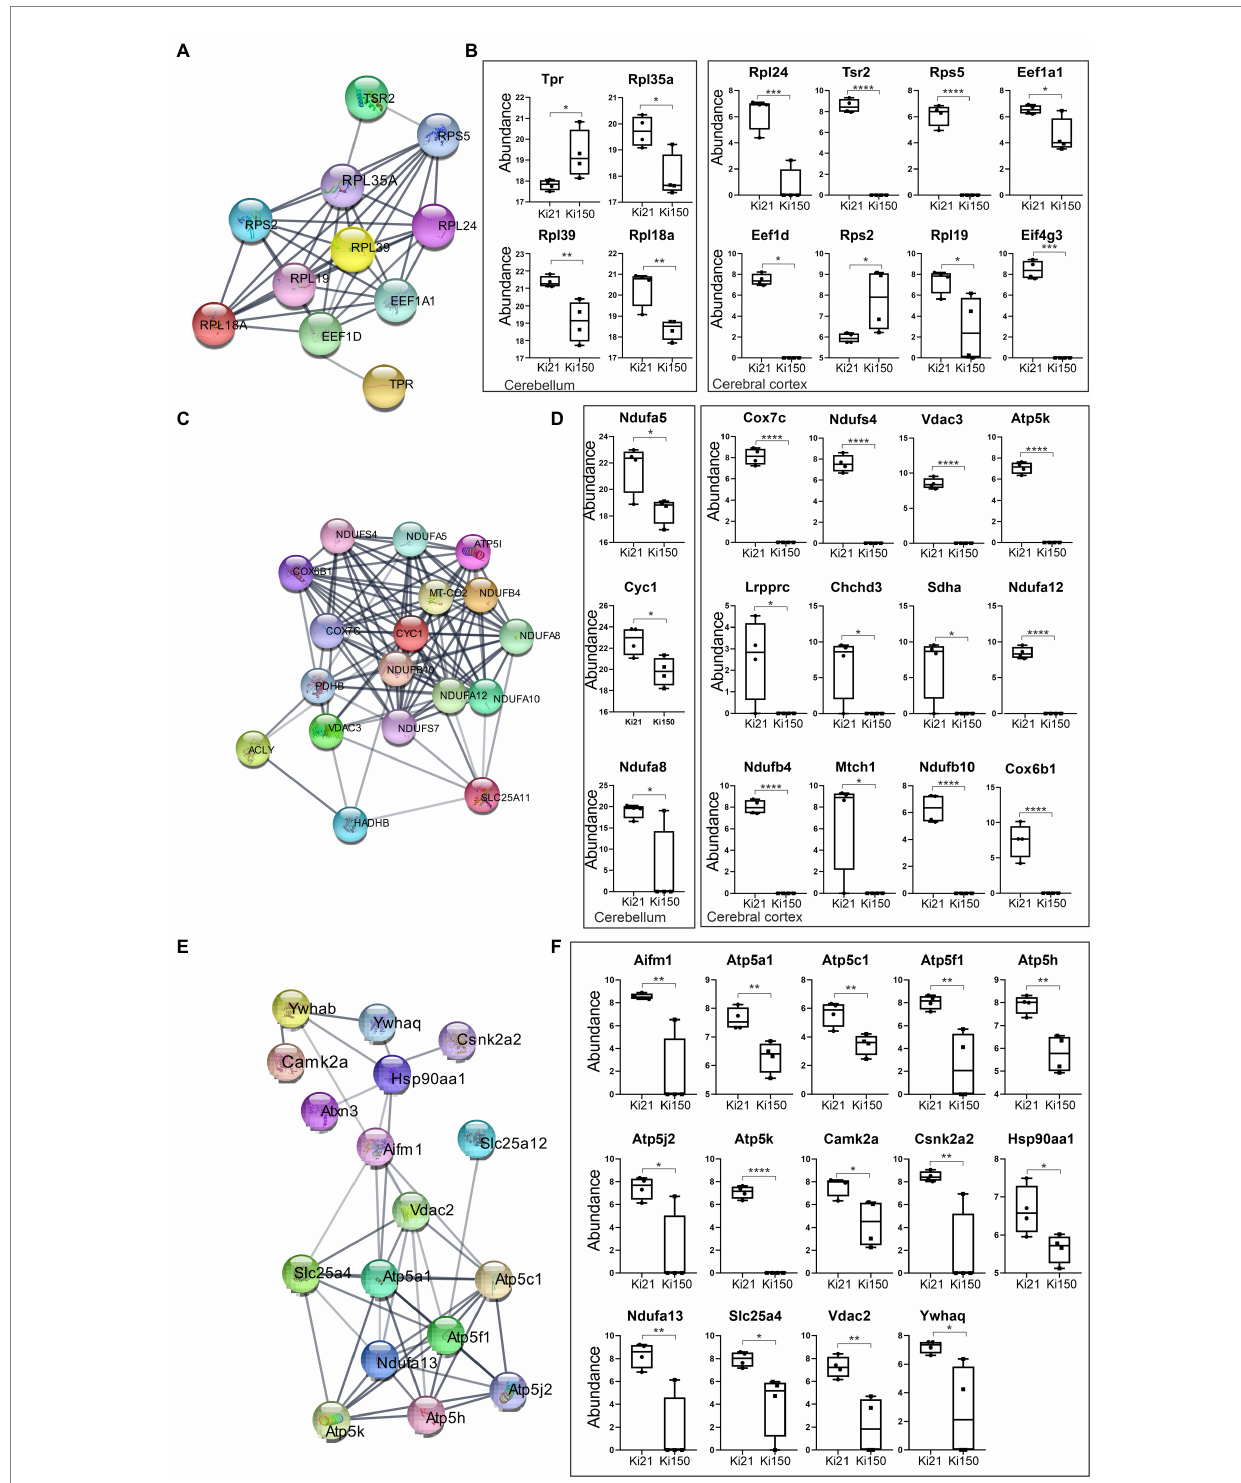
FIGURE 6 IP-LC–MS/MS proteomic analysis of ataxin-3 partners reveals 3 sets of proteins with significantly weakened interaction with the mutant ataxin-3 in the Ki150 SCA3/MJD cerebellum and cortex. The network of proteins displaying weakened interaction with the ataxin-3 containing expanded polyQ tract in the cerebellum (A,C) and cerebral cortex (A,C,E) of Ki50 mice were generated using String database and clustering (STRING Network p < 10e-16) (https://string-db.org/). Diagrams demonstrate relative levels of proteins after their pull-down and proteomic analysis (Ki150 vs. Ki21) reflecting the change or even complete loss of protein interaction with mutant vs. normal ataxin-3 in the cerebellum and cerebral cortex ( B,D,F ; p < 0.05; two-sample t -test). (A,B) The first cluster contained proteins related to the translation in the cerebellum and cerebral cortex. (C,D) The mutant ataxin-3 demonstrated very weak interactions with mitochondrial proteins (second cluster) in the Ki150 cerebellum and Ki150 cerebral cortex. (E,F) The third set of proteins with diminished interaction with mutant ataxin-3 (150 CAG repeats) in the cerebral cortex is involved in mitochondrial transport. Two- sample t -test ( p ≤ 0.05; * p < 0.05, ** p < 0.01, *** p < 0.001); total number of biological replicates: n = 8, n = 4 per genotype; error bars: